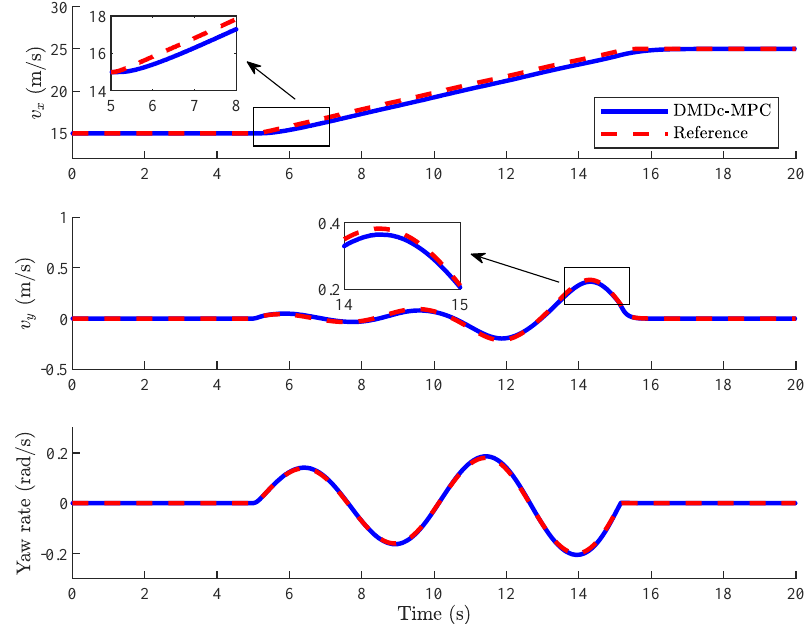
Figure 13. State evolution of DMDc-MPC (Case 2).